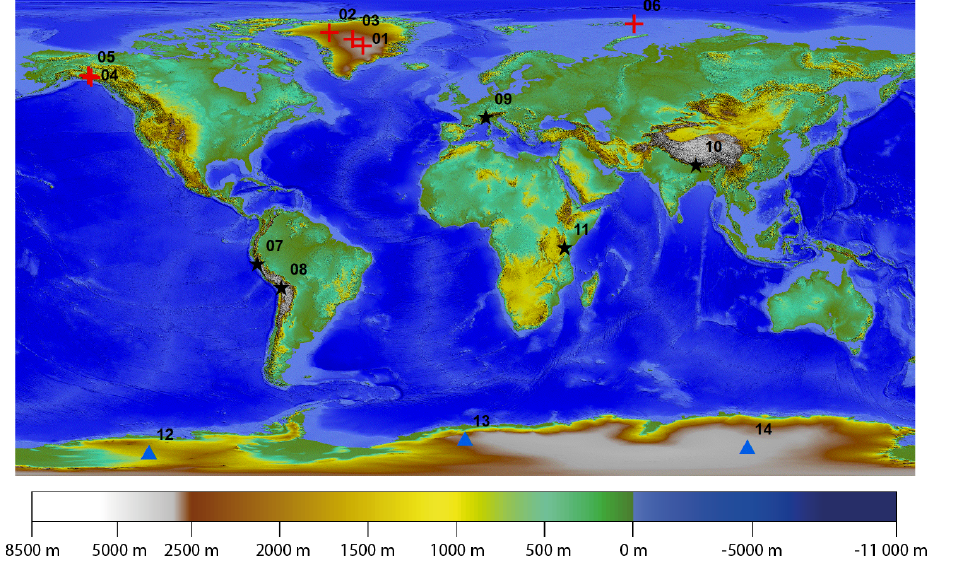
Figure 1. Topographic height (colour bar, in metres) and the location of the ice-core sites. The red crosses refer to sites in the Arctic Domain, the black stars in the Central Domain, and the blue triangles in the Antarctic Domain. The numbers are defined in Table 1. Table 1. Characteristics of the ice-core sites